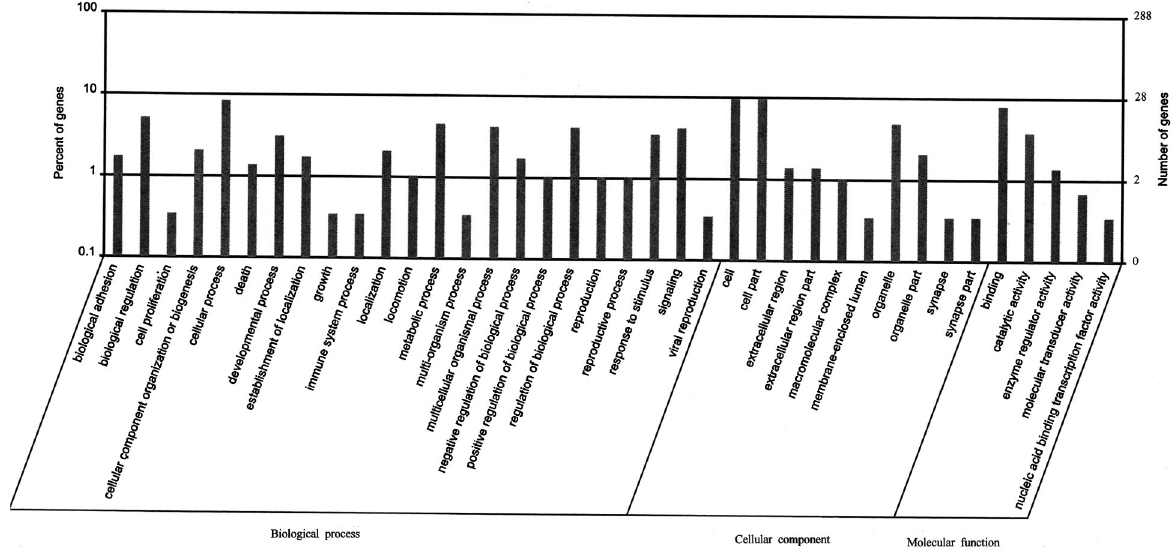
Figure 3. Distribution of peaks relative genes by Gene Ontology (GO) analysis (AmiGO 1.8). The lateral axis represents the GO terminology. The left vertical axis represents the proportion of the related genes. The right vertical axis represents the number of the related